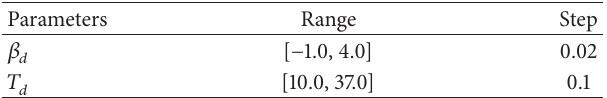
Table 2: Range of values considered for the parameters of the thermal dust emissivity model. Parameters